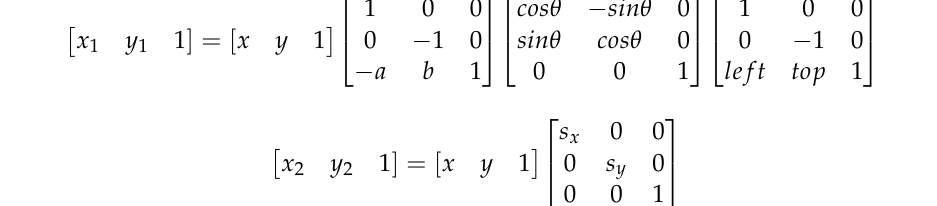
The results are shown in Figure 4.